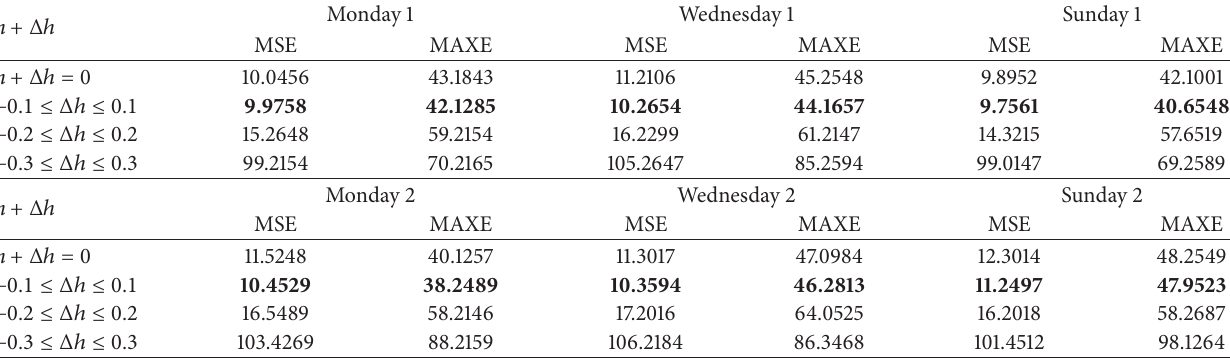
Table 2: The result of adding the correction mechanism.